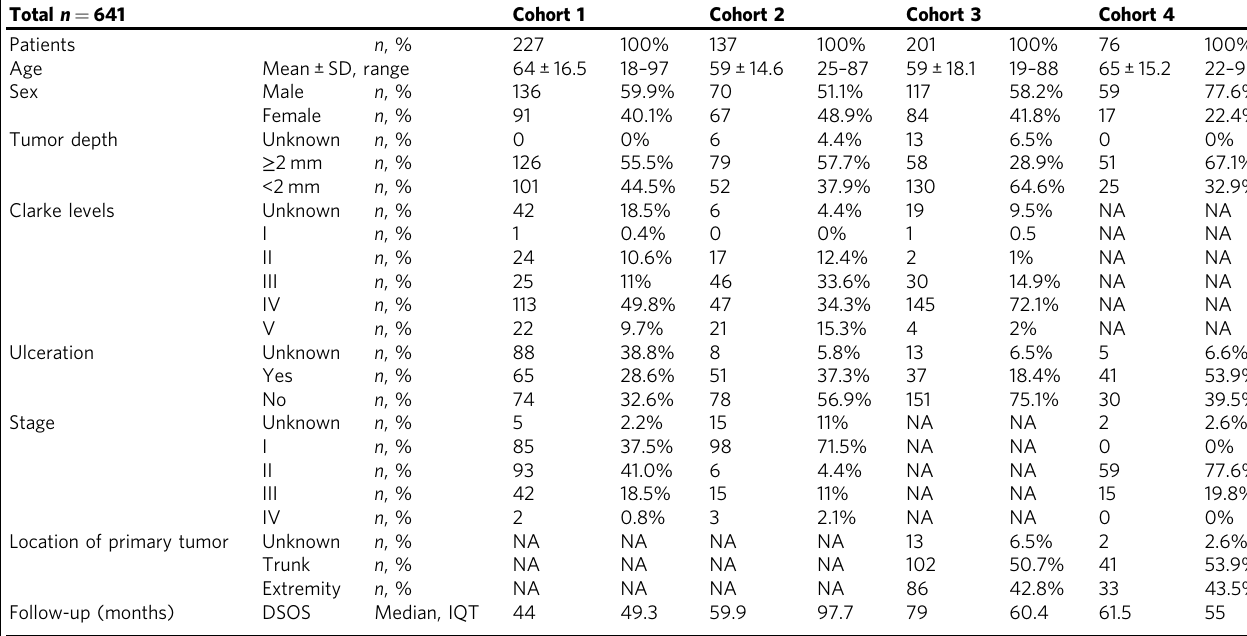
Table 2 Clinicopathological data of the patients. Total n = 641